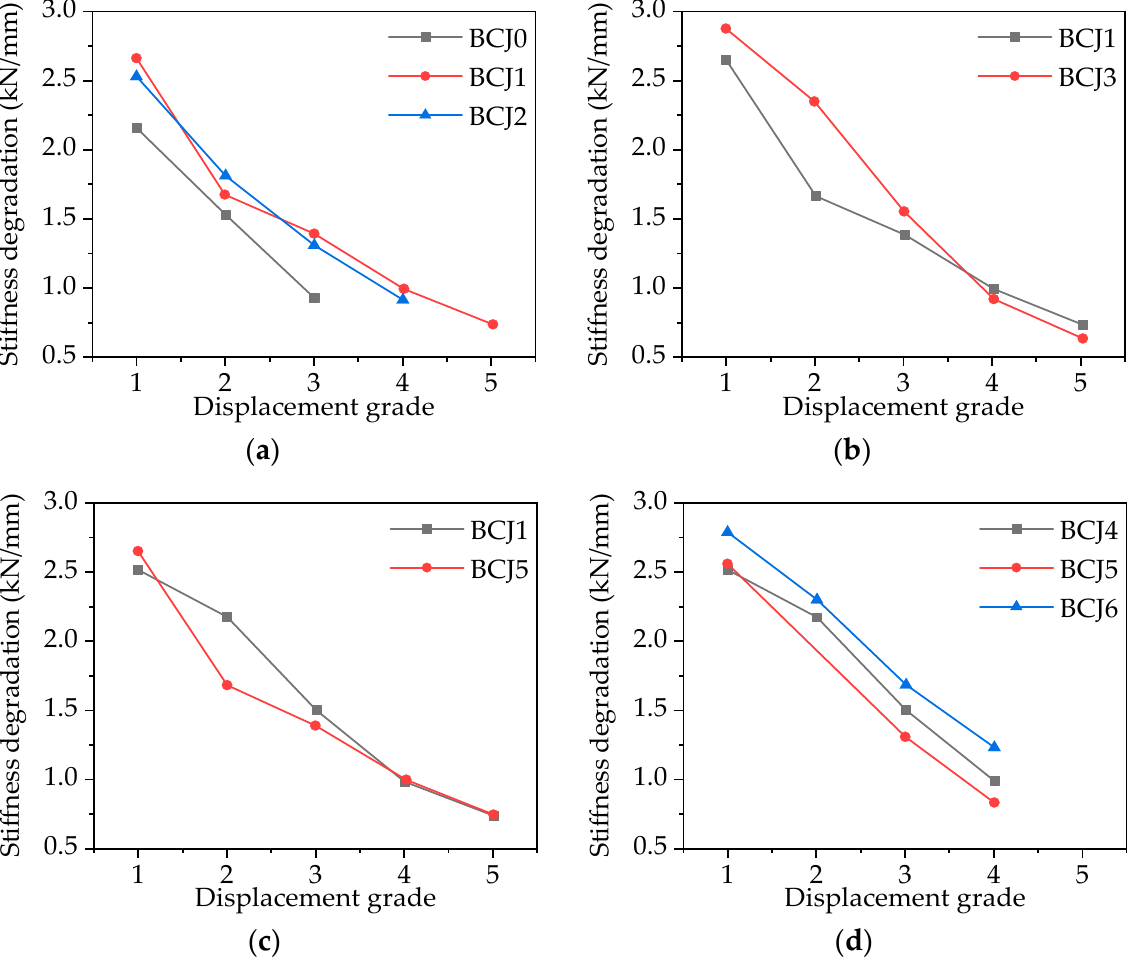
Figure 17. Relationship between stiffness degradation and displacement grade with: ( a ) Different volume ratios of steel